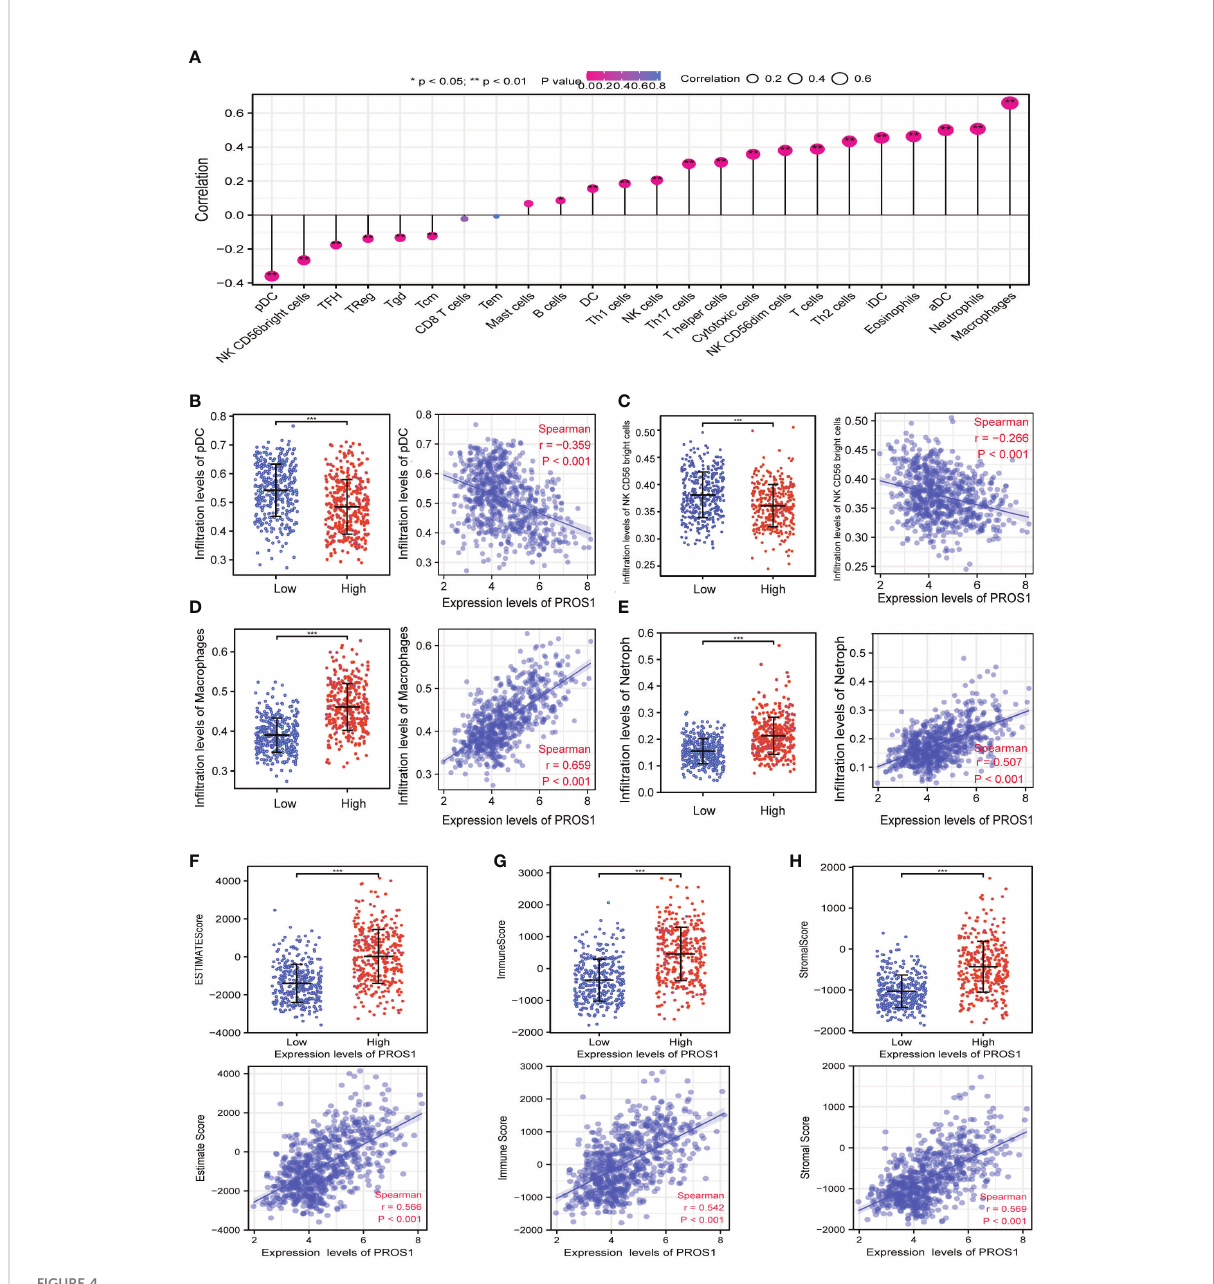
FIGURE 4 The relationship of immune cell in fi ltration and tumor immune microenvironment with PROS1 expression in GBM and LGG. (A) The relationship between PROS1 expression and the immune cell in fi ltration analyzed by ssGSEA in glioma. The PROS1 expression levels had a signi fi cant correlation with the in fi ltration of (B) pDCs, (C) NK CD56 Bright cells, (D) Macrophages, and (E) Neutrophils in glioma. The correlation of PROS1 expression level with (F) EstimateScore, (G) ImmuneScore, and (H) StromalScore in the high PROS1 and low PROS1 group in glioma. (*, P < 0.05; **, P < 0.01; ***, P <